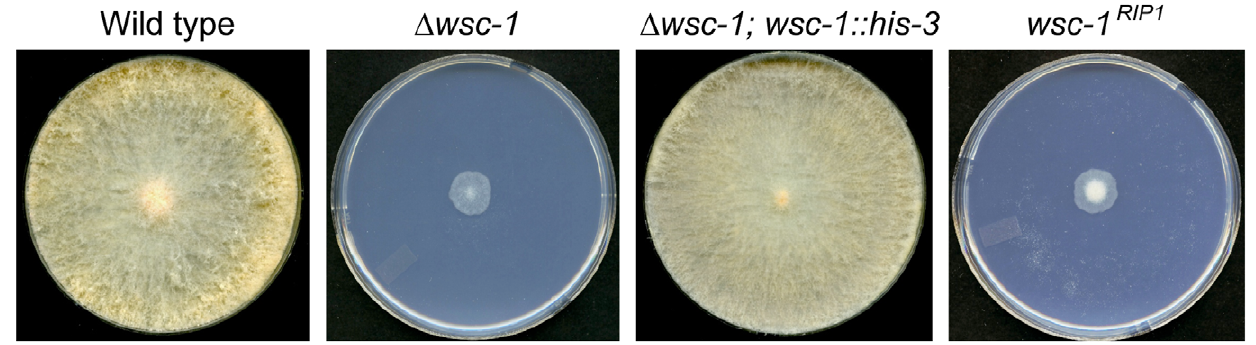
Figure 1. Complementation and RIP analysis of wsc-1 . Colony morphologies are shown for wild type, D wsc-1 , a transformant of D wsc-1 containing a wild type copy of the wsc-1 gene inserted at the his-3 locus, and the wsc-1 RIP1 mutant grown for 24 hours on a Vogel’s sucrose agar medium.